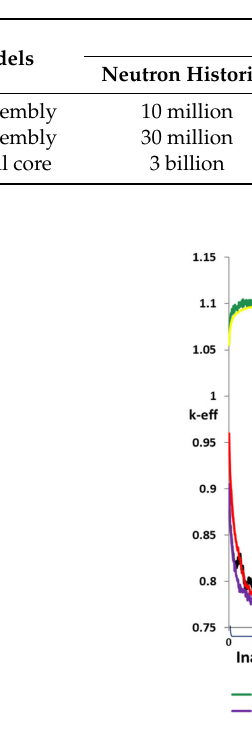
Figure 9. Convergence of fission source entropy for the EPR 3D full-core simulation using